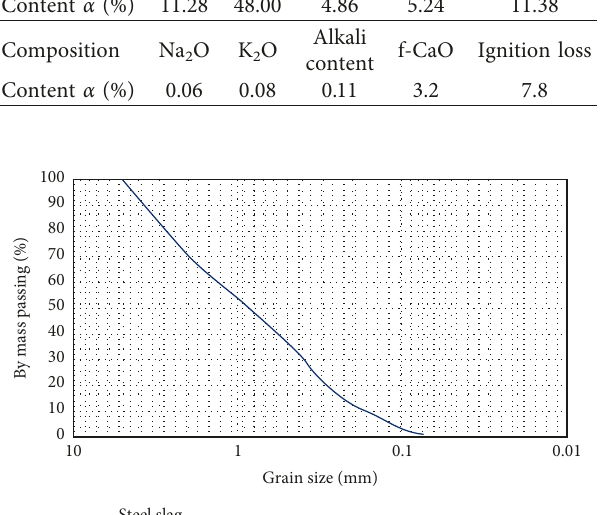
Figure 2: Grain distribution of test steel slag.